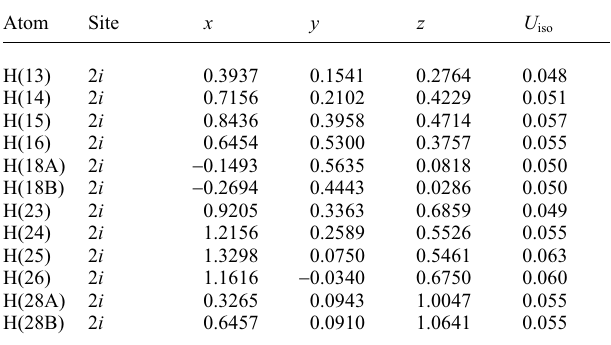
Table 2. Atomic coordinates and displacement parameters (in Å 2 )